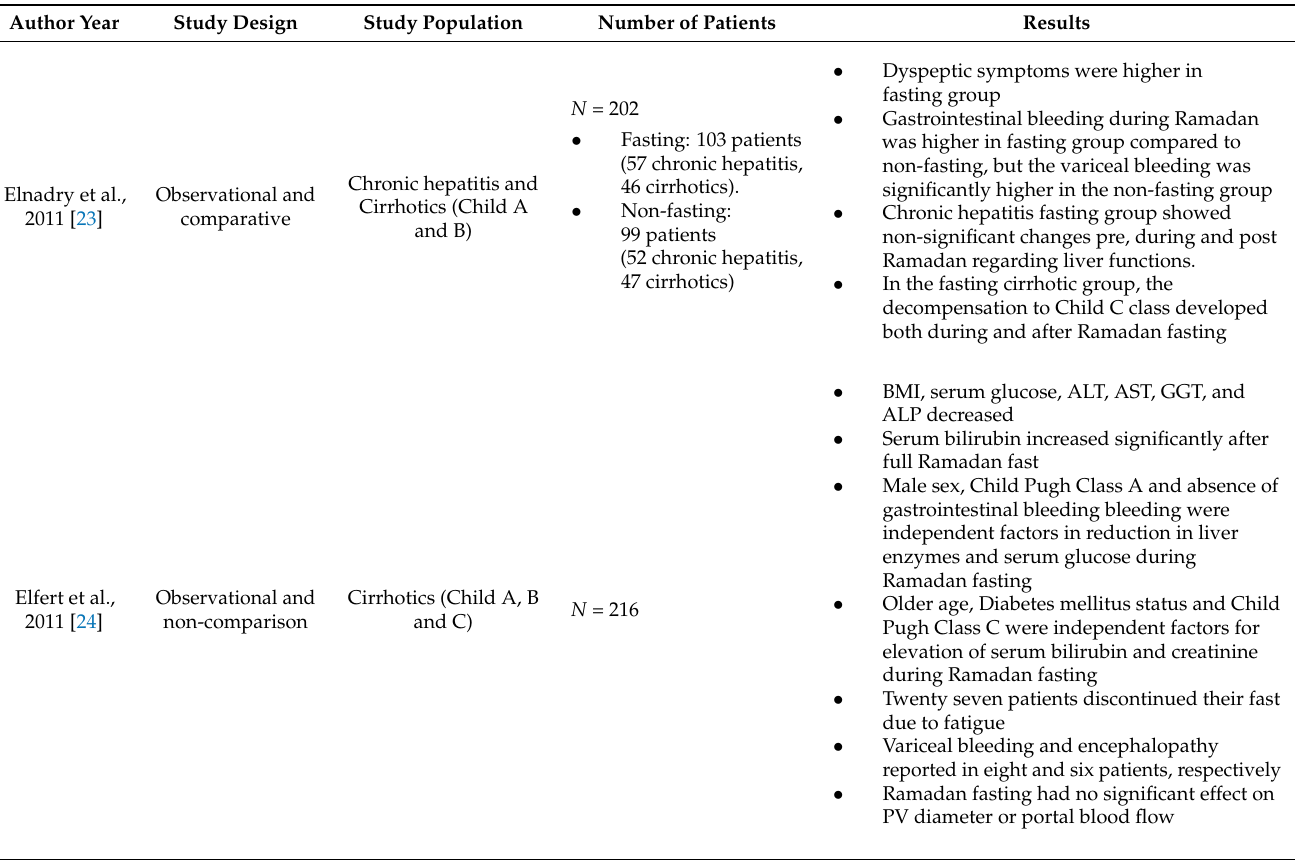
Table 1. The effects of Ramadan fasting in cirrhotic